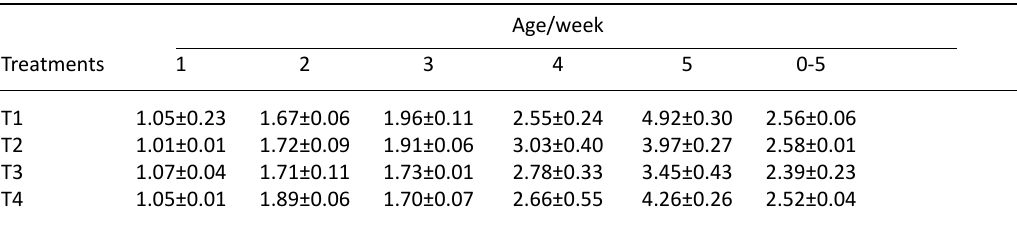
Table 5. Effect of fermented maize by S.cerevisiae in diets on the feed conversion ratio (feed/gain) of broiler chicks for 5 weeks